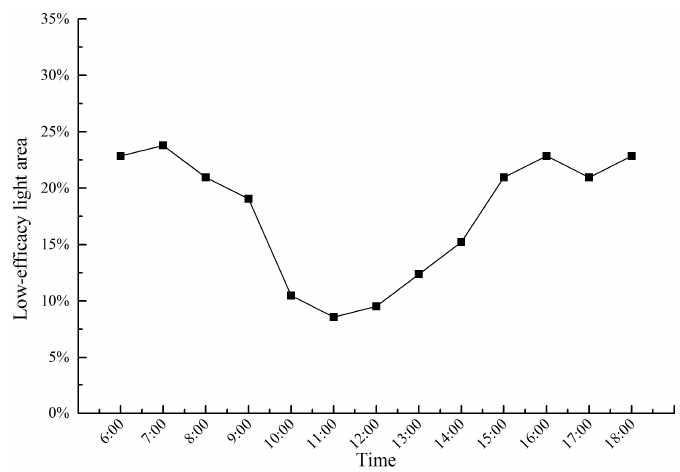
Figure 13. The proportion of the low-efficacy light area to the whole canopy.